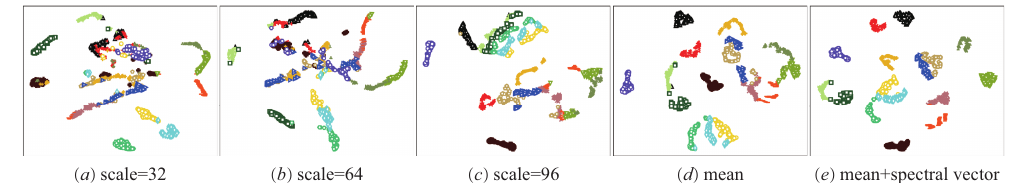
Figure 10. Visual presentation of the learned features under different settings in ablation studies. Different colors represent different